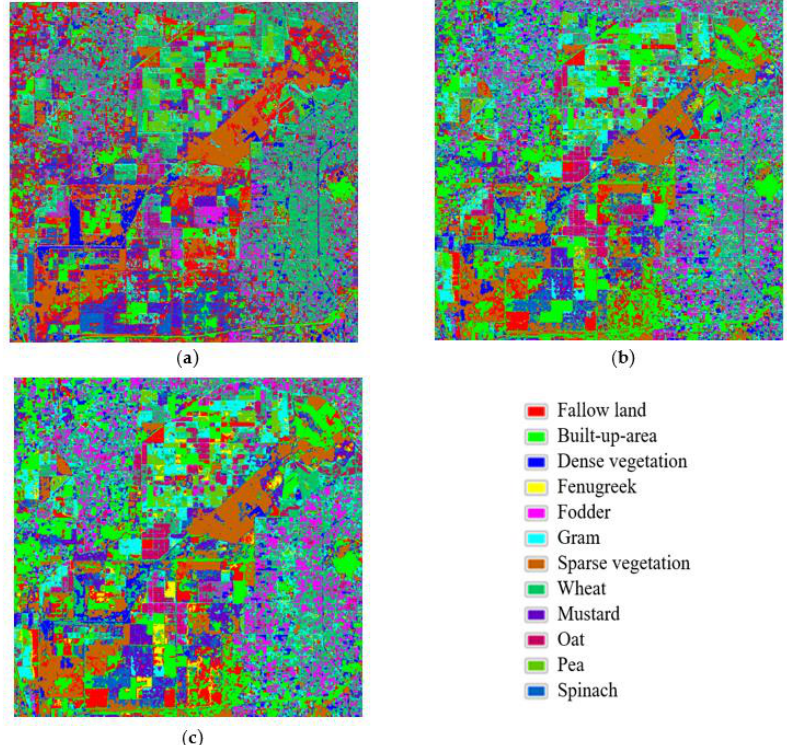
Figure 5. Classified images for VH polarization using ( a ) SGD, ( b ) SGB, and ( c ) XGB classifier with patch size = 3.